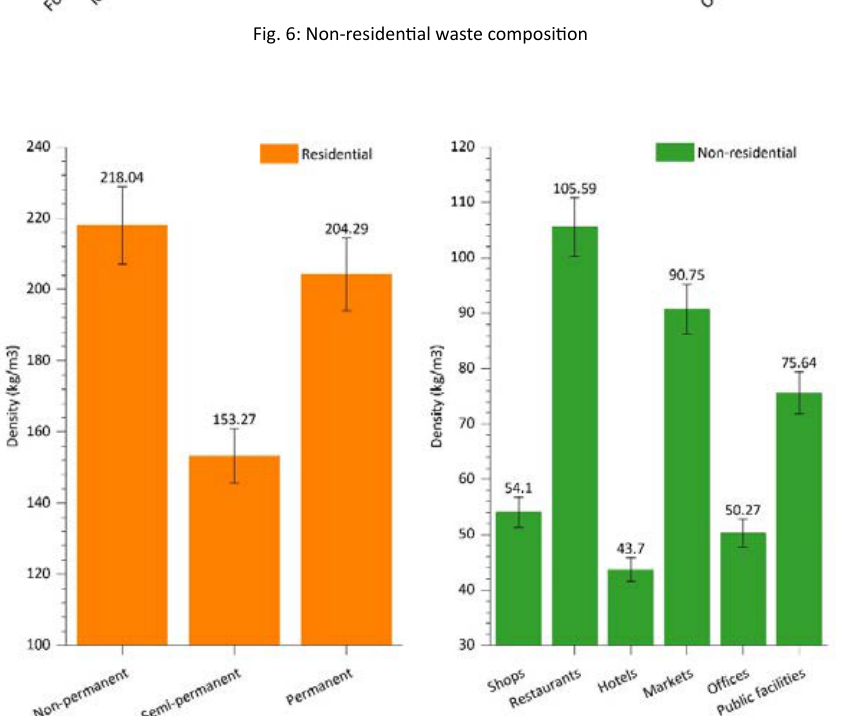
Fig. 6: Non-residential waste composition Fig. 6: Non‐residential waste composition